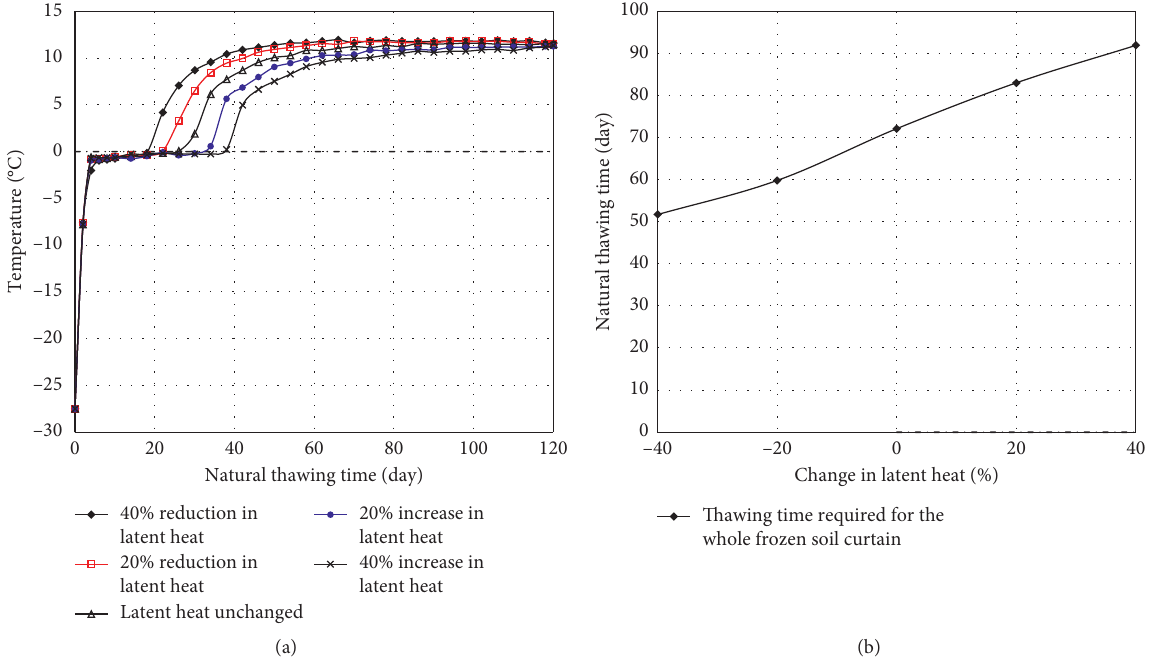
Figure 14: Effects of latent heat on the temperature-thawing time response and required thawing time for frozen soil curtain: (a) temperature-thawing time response at X � 3 m (monitor point 2); (b) variation of required thawing time with latent heat change.